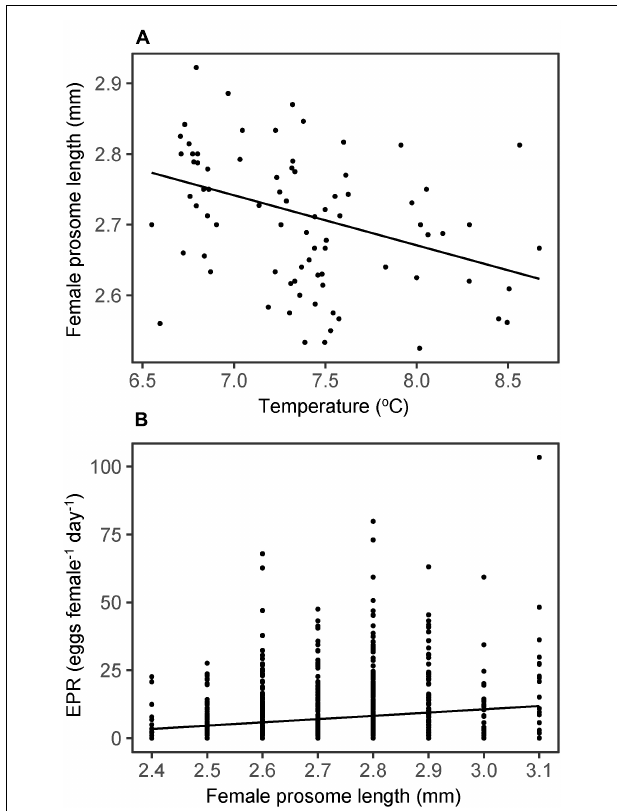
FIGURE 8 | (A) Mean female size (prosome length) vs. temperature (6–50 m) at a given station [ PL = 3.17-0.06 (T)] and (B) individual egg production rates (eggs female − 1 day − 1 ) vs. female size [EPR = -25.61 + 12.07 (PL)].